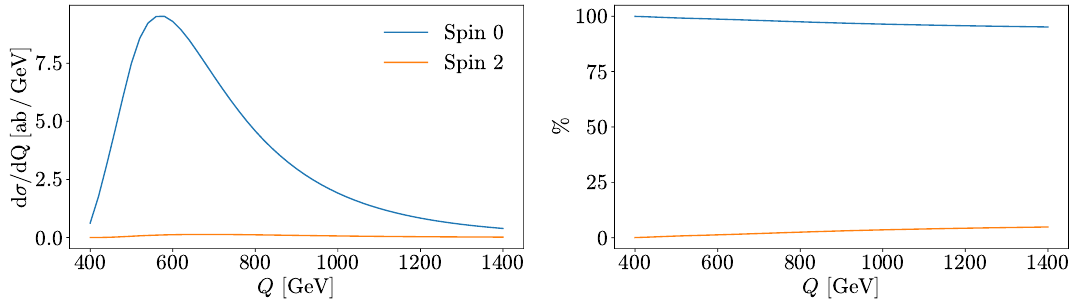
Figure 2 . Spin 0 ( (cid:24) jM ++ j 2 ) and Spin 2 ( (cid:24) jM + (cid:0) j 2 ) contributions to the invariant mass distribution of the triple Higgs system for collider CM energies of 100 TeV. The left plot shows the absolute contributions, while the right one shows the